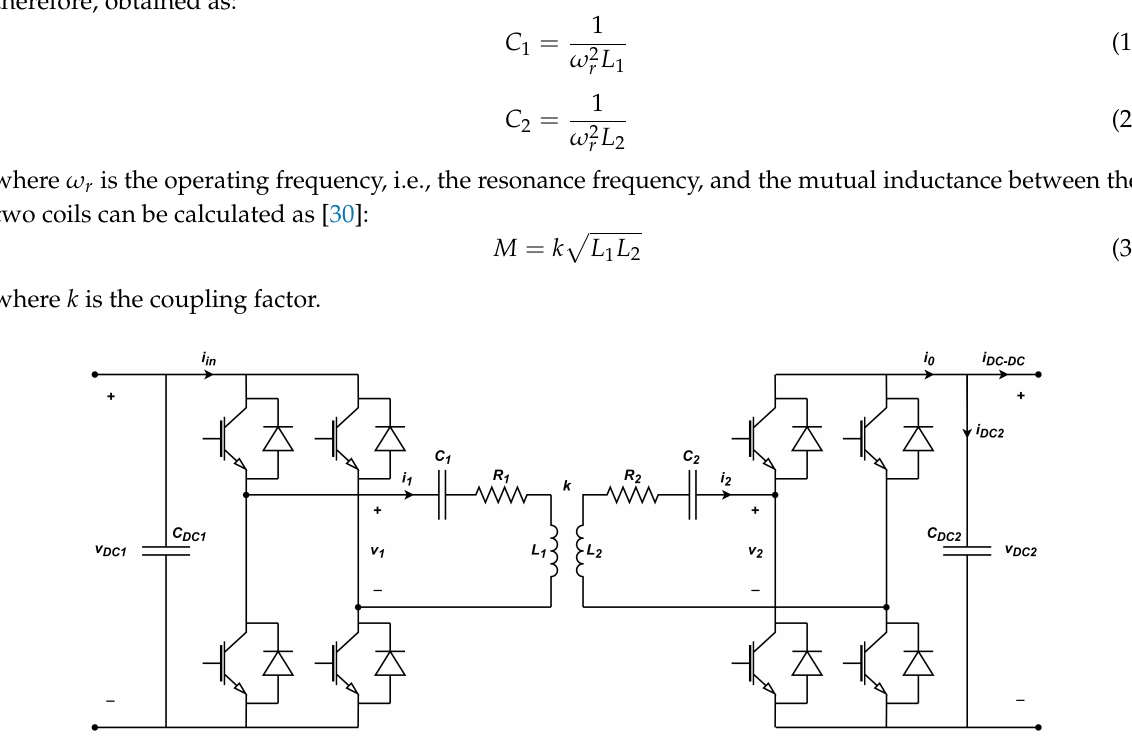
Figure 3. Compensated magnetic coupler and its associated bidirectional H-bridge